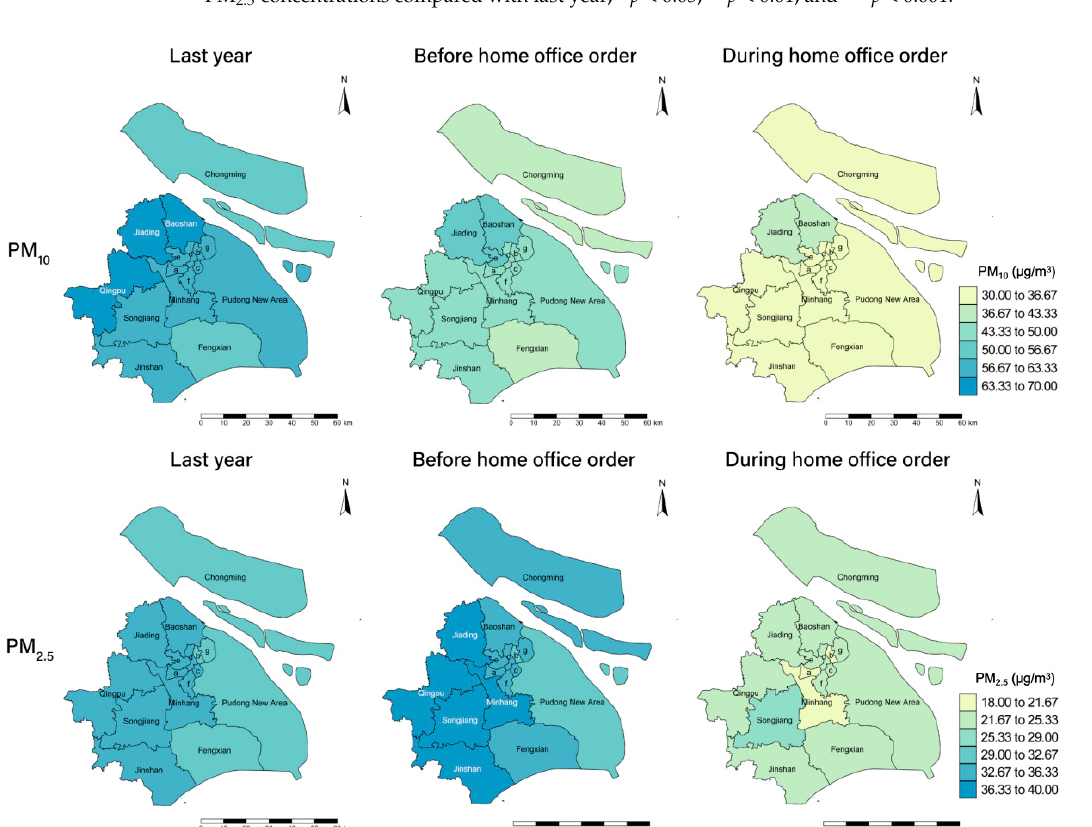
Figure 3. The calendar heatmaps of daily PM 10 and daily PM 2.5 concentrations before and during implementing the home office order in Shanghai. ITS analysis was used to analyze the changes in PM 10 and PM 2.5 concentrations be- fore and during the implementation of the home office order. As shown in Figure 4, the solid line with white background represented the regression line before the implementa-